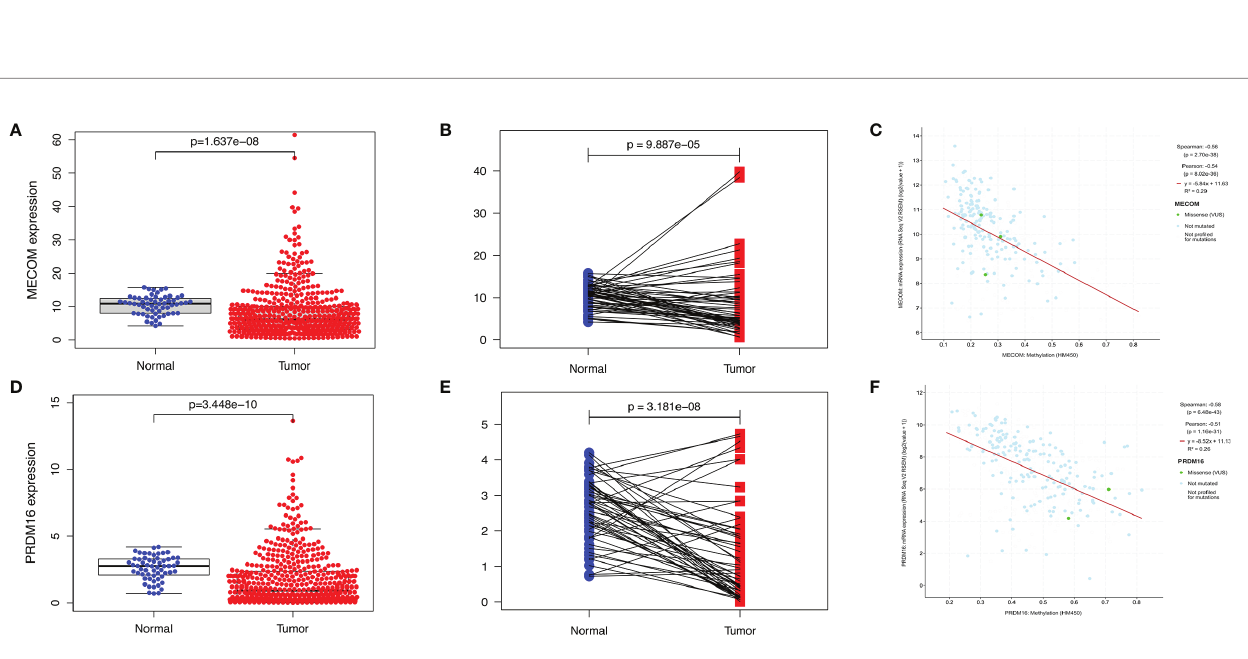
FIGURE 2 | Expression of MECOM and PRDM16 in LUAD. (A, D) mRNA levels of MECOM (A) and PRDM16 (D) in LUAD tissues in TCGA. (B, E) MECOM (B) and PRDM16 (E) mRNA expression levels in paired tumor and adjacent normal tissues of 57 patients with LUAD in TCGA. (C, F) Correlation scatter plot of MECOM (C) and PRDM16 (F) mRNA expression and its methylation levels in LUAD in the cBioPortal database. MECOM, MDS1 and EVI1 complex locus, also called PRDM3; PRDM16, PR domain containing 16, also called MEL1; LUAD, lung adenocarcinoma.